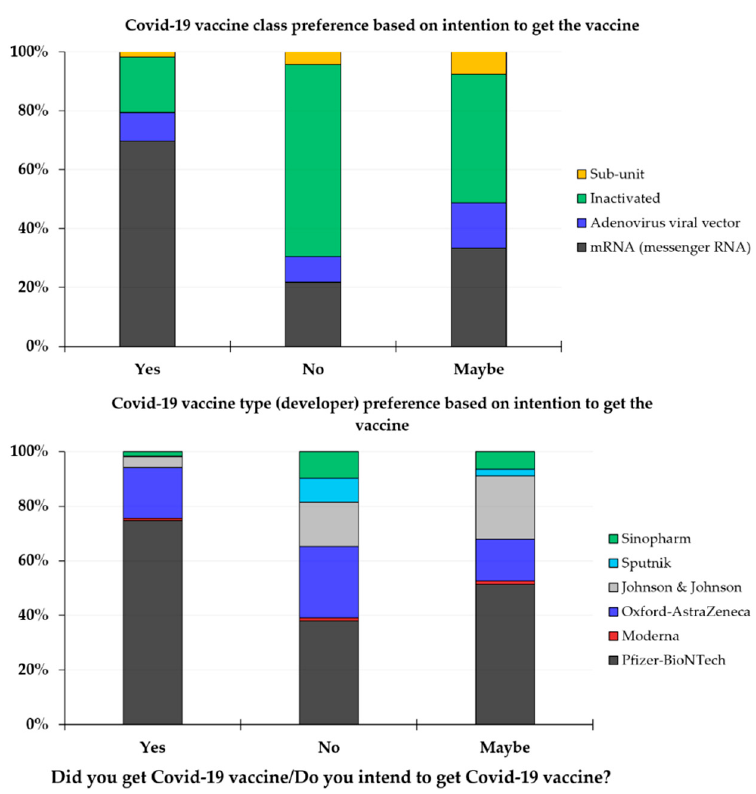
Figure 1. The preference of COVID-19 vaccine class and type (developer) stratified based on intention to receive vaccination.